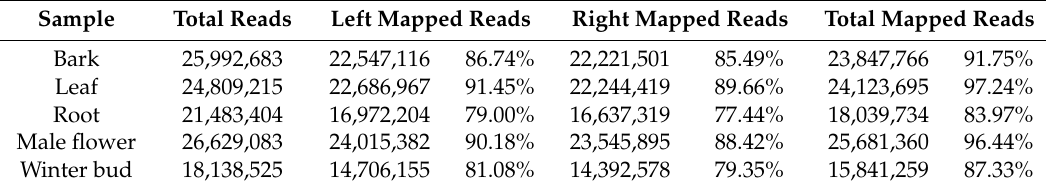
Table 1. RNA- seq data production and alignment results for reads of different tissues.